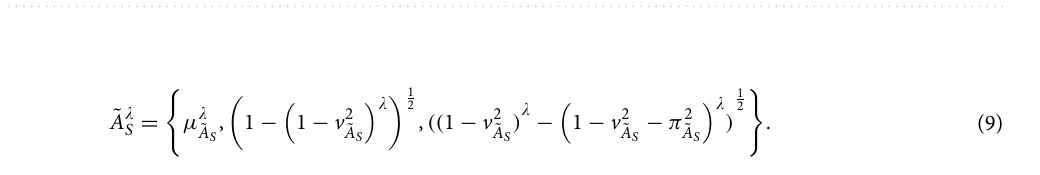
Table 3. SF-AHP linguistic terms used for pairwise